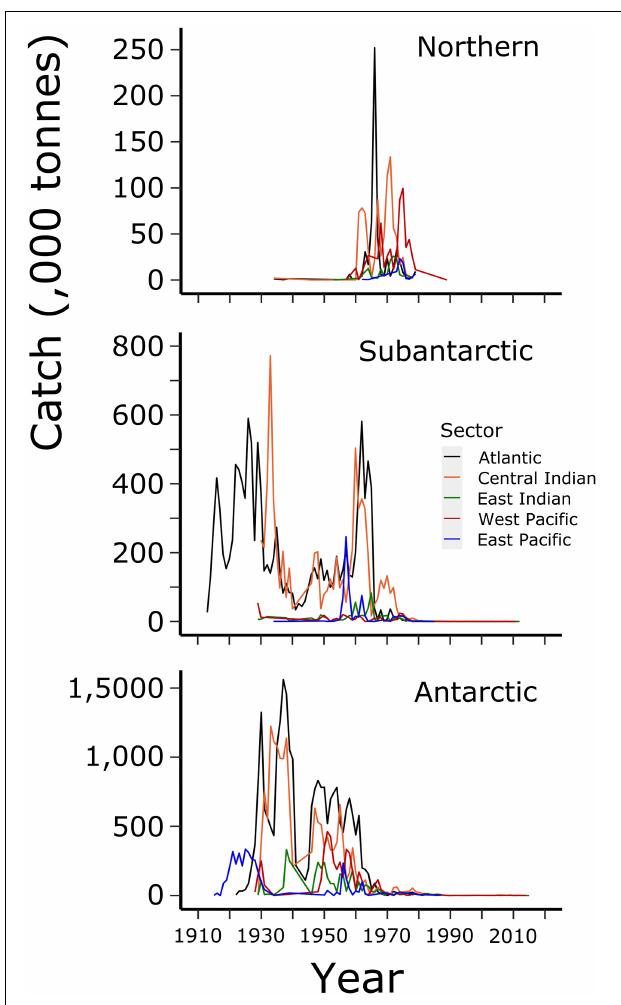
FIGURE 6 | Time series of catches (tonnes) of all Southern Ocean cetaceans in each sector (central right legend) from each zone (labelled panels) of MEASO areas as shown in Figure 2 . Data from IWC Catch